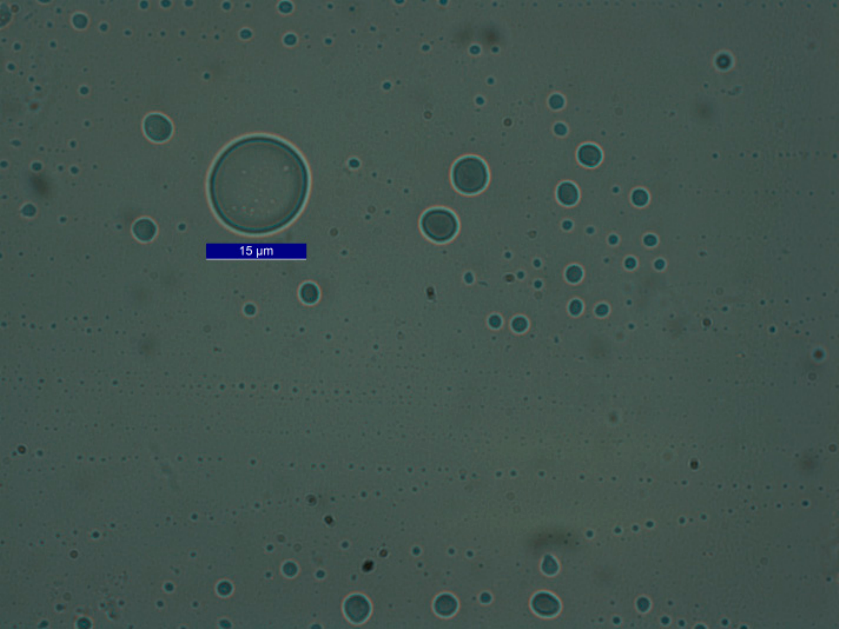
Figure 1. Optical microscopy images of whey protein concentrate/soy protein isolate/gum arabic (WPC/SPI/GA) complex